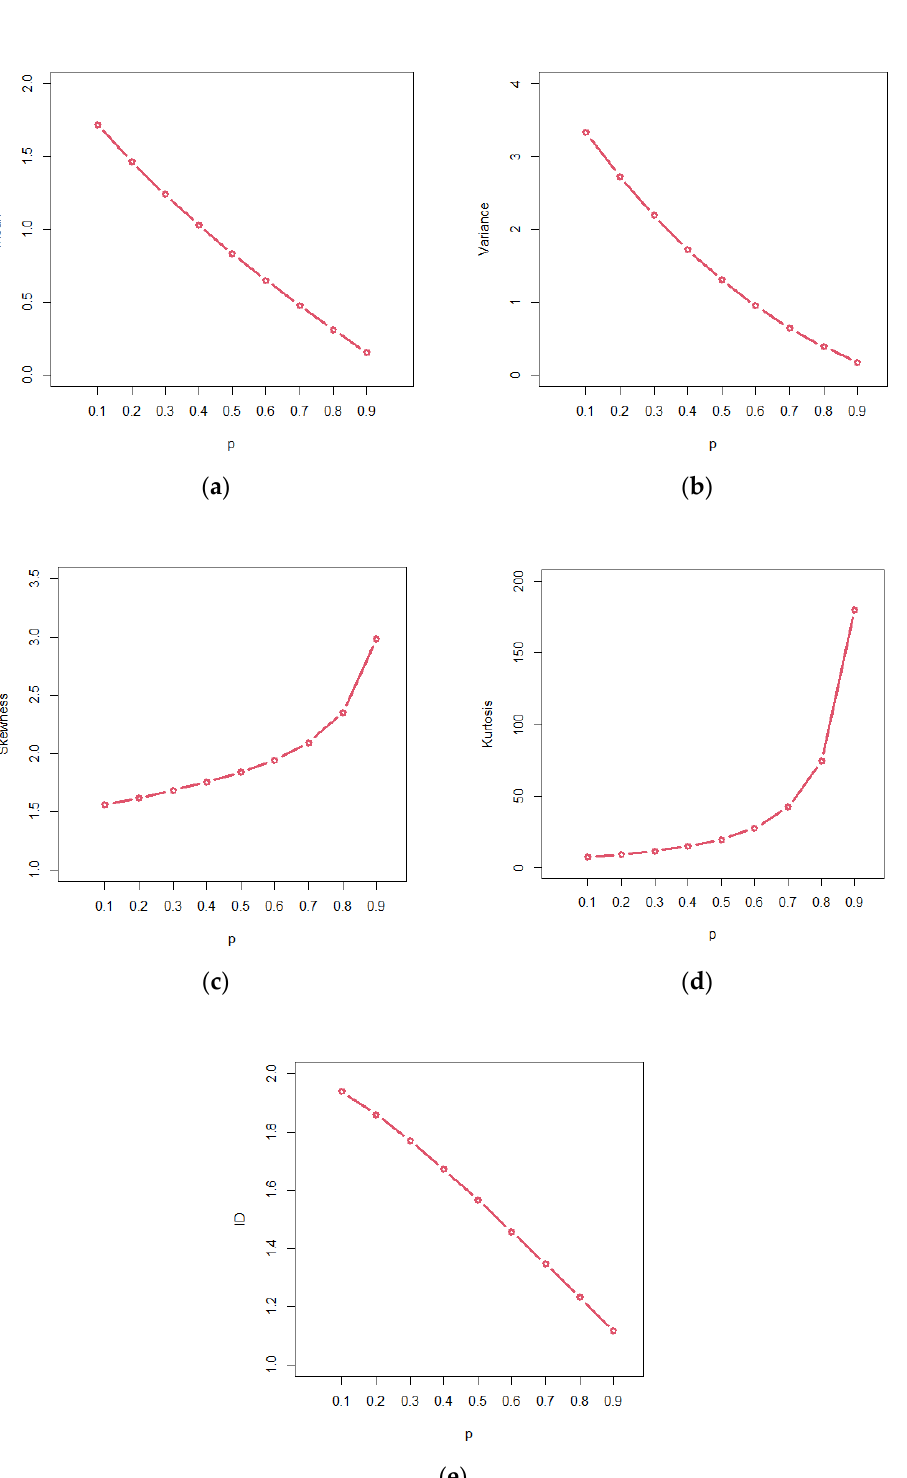
Figure 4. Plots of the BNDL model for ( a ) Mean, ( b ) Variance, ( c ) Skewness, ( d ) Kurtosis and ( e ) ID.